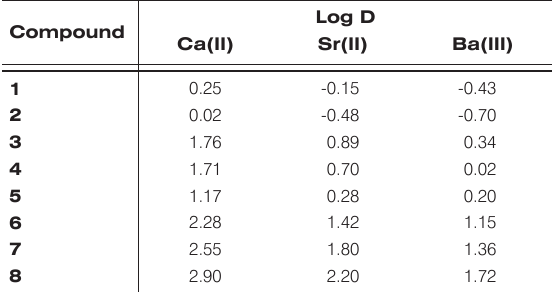
separation factors for the lanthanides(III) extraction from 4 M NH NO solutions with compounds 1 - 8 in 4 3 1,2-dichloroethane and from aqueous Ln(NO with compounds 1 - 8 in 1,2-dichloroethane containing SF Lu/La 1,2-